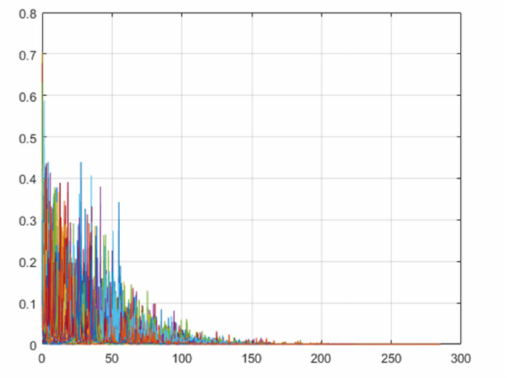
Figure 22. Signal strength vs. distance graph.